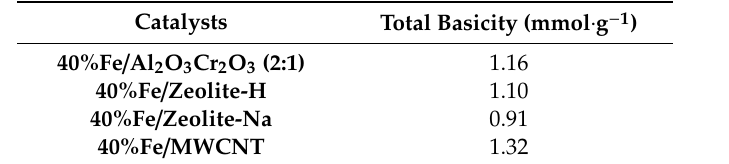
Table 5. The amount of carbon dioxide adsorbed on the reduction at 500 ◦ C in a mixture of 5%H 2 -95%Ar and iron catalysts calculated from the surfaces under the TPD-CO 2 profiles.